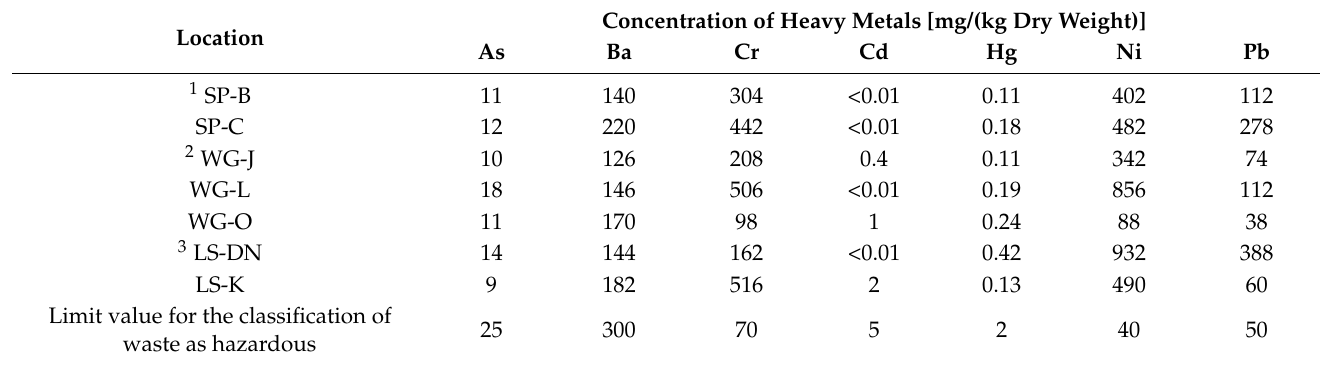
Table 1. Concentration of selected heavy metals in black powder samples.